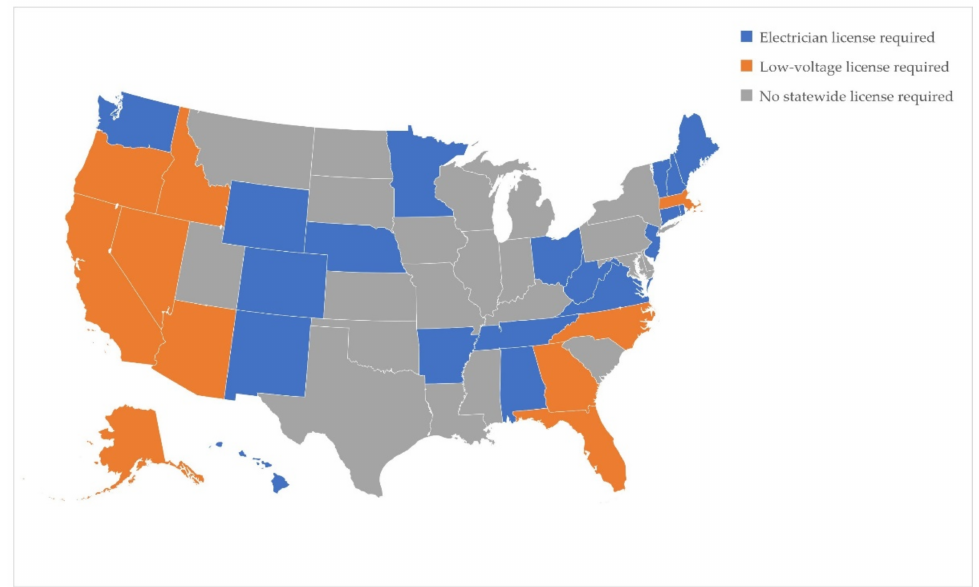
Figure 3. Statewide electrical licensing requirements for installation of low-voltage lighting. Source: